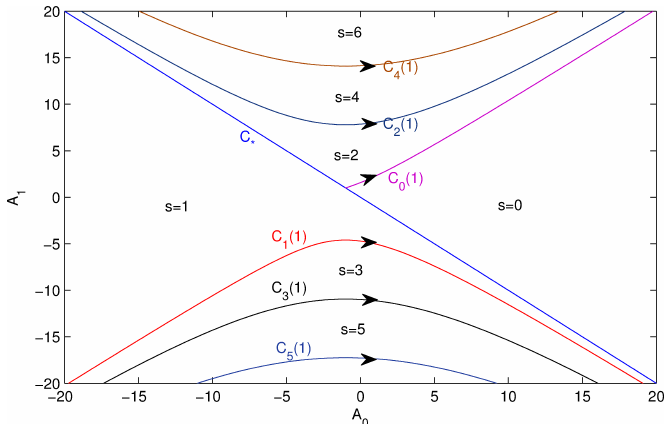
Fig. 1. The member of the D-curves family C k .h/ in the parameter space .A 0 ;A 1 / for h D 1 . The arrows along the curves refer to the direction of increasing ! . The numbers s in the different regions bordered by the curves indicate the number of roots in the right half